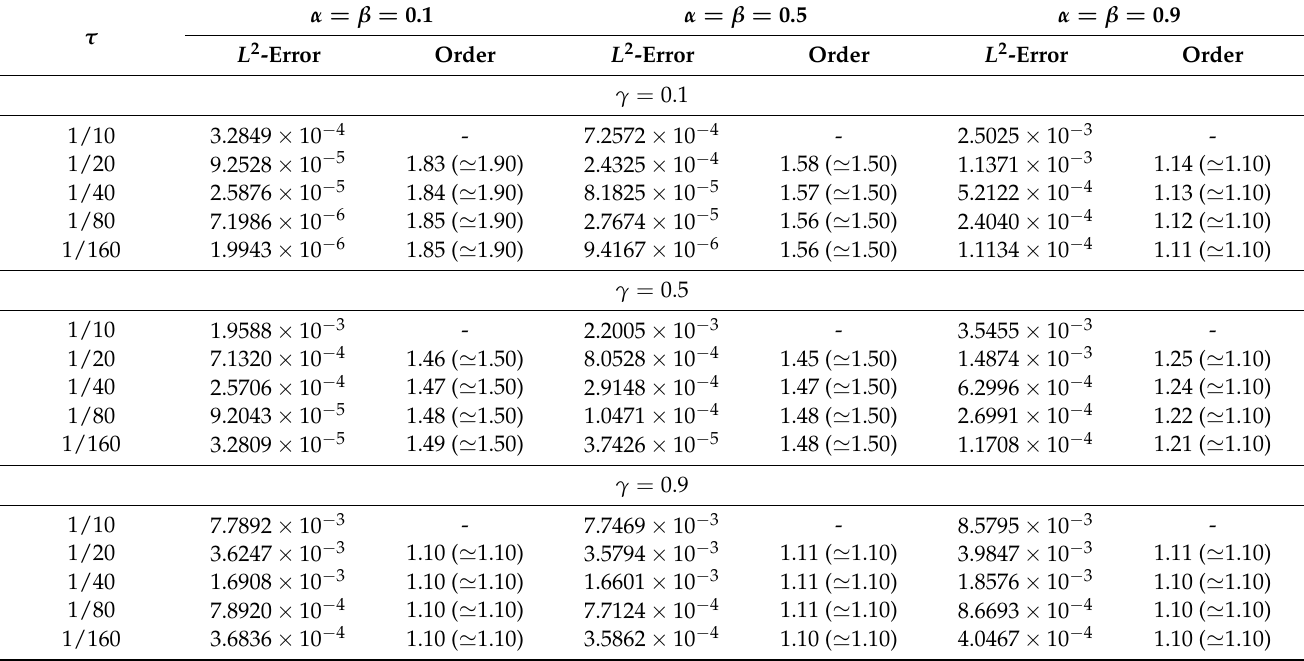
Table 1. L 2 -errors and convergence orders obtained for Example 1 when h = 1/20,000. The numbers in parentheses indicate the theoretical convergence